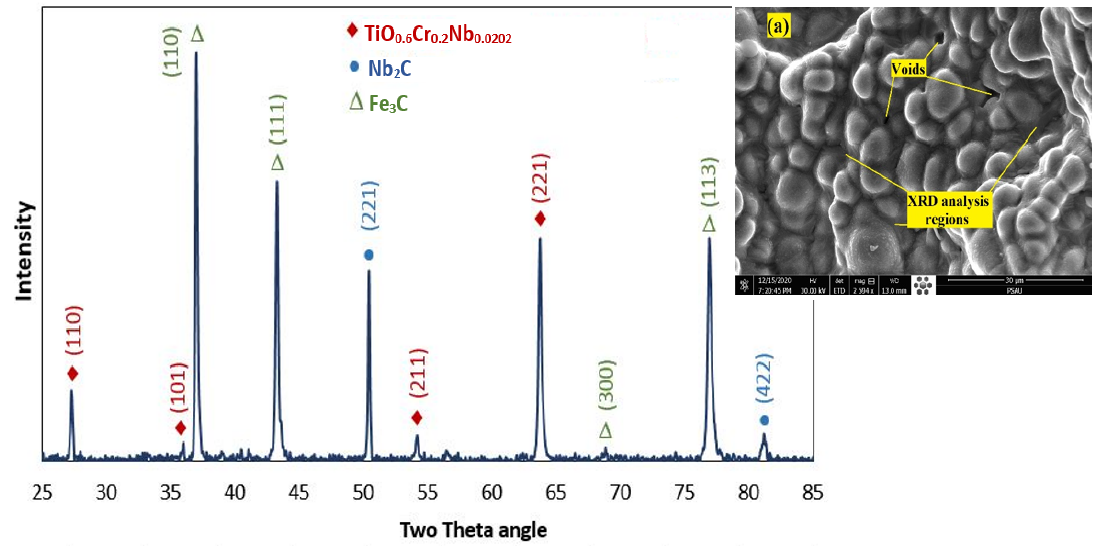
Figure 16. X-Ray Diffraction (XRD) pattern in the solidification hot cracking surface in TIG weld coated with the mixture of powders (80% Nb + 20% Ti), ( a ) XRD analysis regions × 2500.